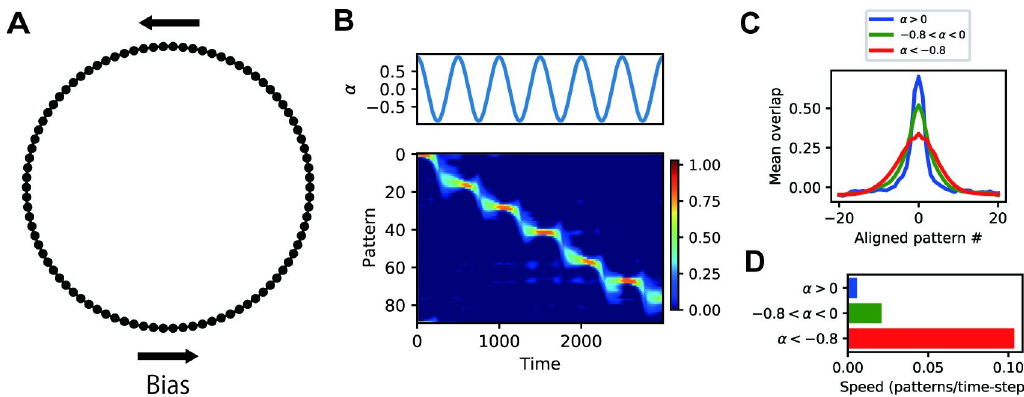
Fig 7. Parameter-dependent sequential activities in asymmetric LAM. (A) A ring structure of hetero-associative links for the simulation of asymmetric LAM. Hetero-associative weights were biased towards one direction. (B) The time course of α (top) and pattern overlaps (bottom) in the simulation of asymmetric LAM. Negative pattern overlaps were truncated to zero. (C) Peak- aligned mean pattern overlap distributions in different ranges of α . (D) Mean speed of the peak shift of the pattern overlap distribution in different ranges of α